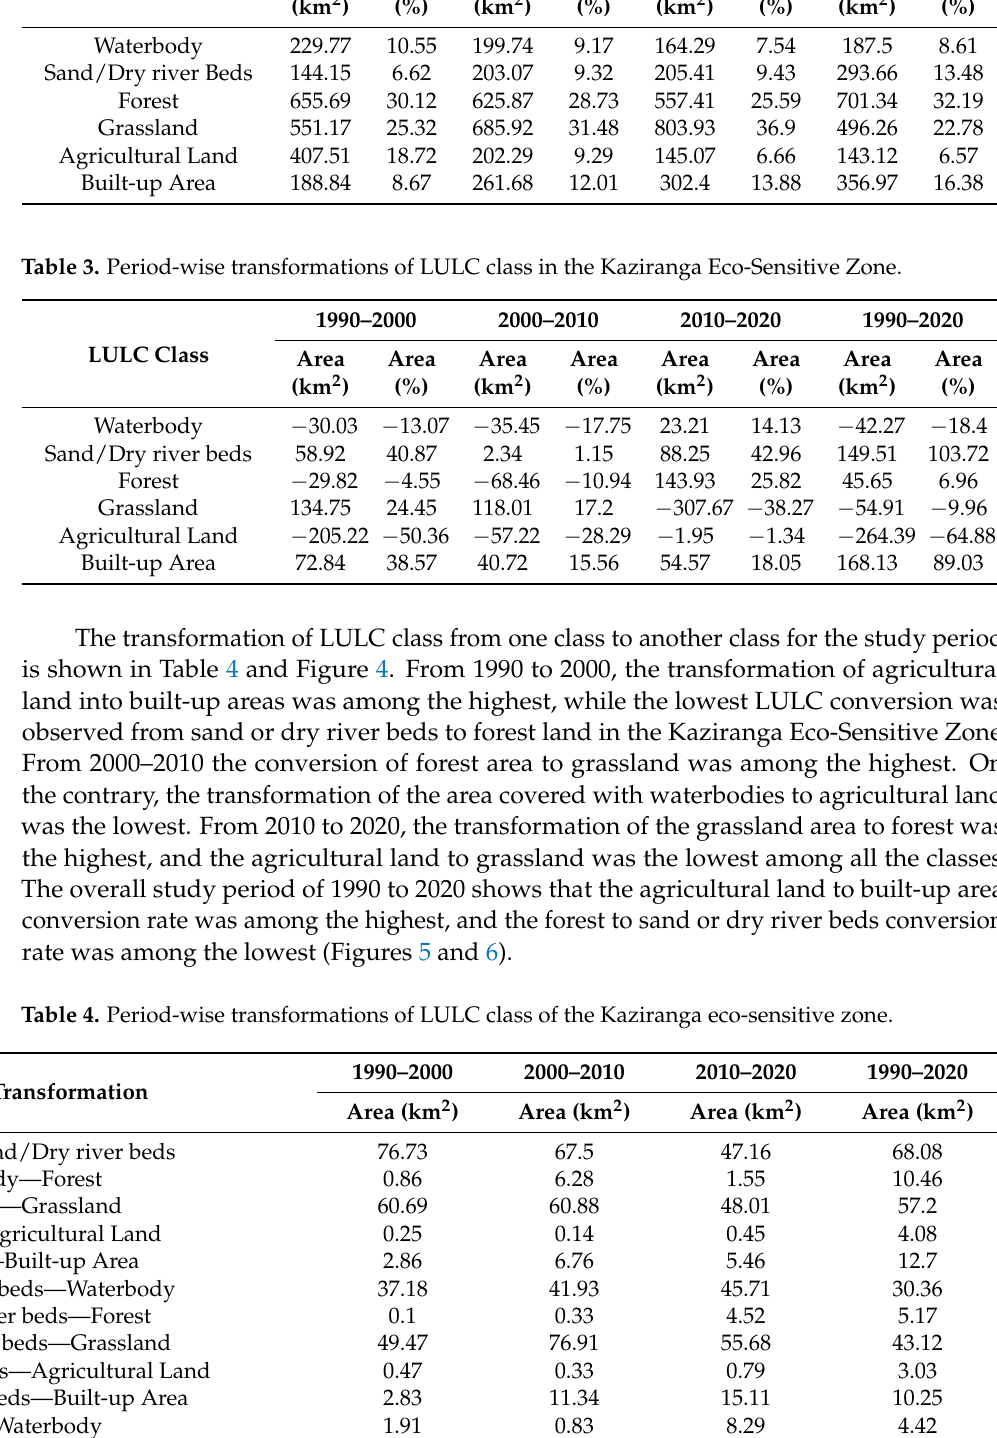
Table 2. Area of the different classified LULC classes of the study area.